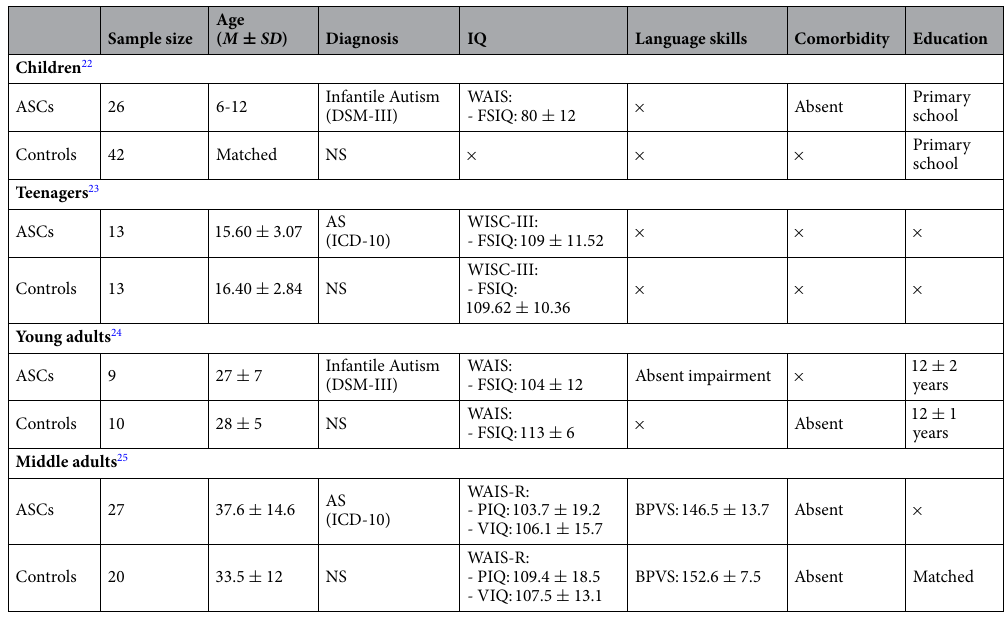
Table 1. Summary of demographic information about the four selected studies. Matched not provided information, which however is matched with that of the experimental sample. Absent absent comorbidities. × not provided information, NS not significant information (e.g., control groups are neurotypical by definition), AS asperger syndrome, FSIQ Full Scale Intelligence Quotient, PIQ Performance Intelligence Quotient, VIQ Verbal Intelligence